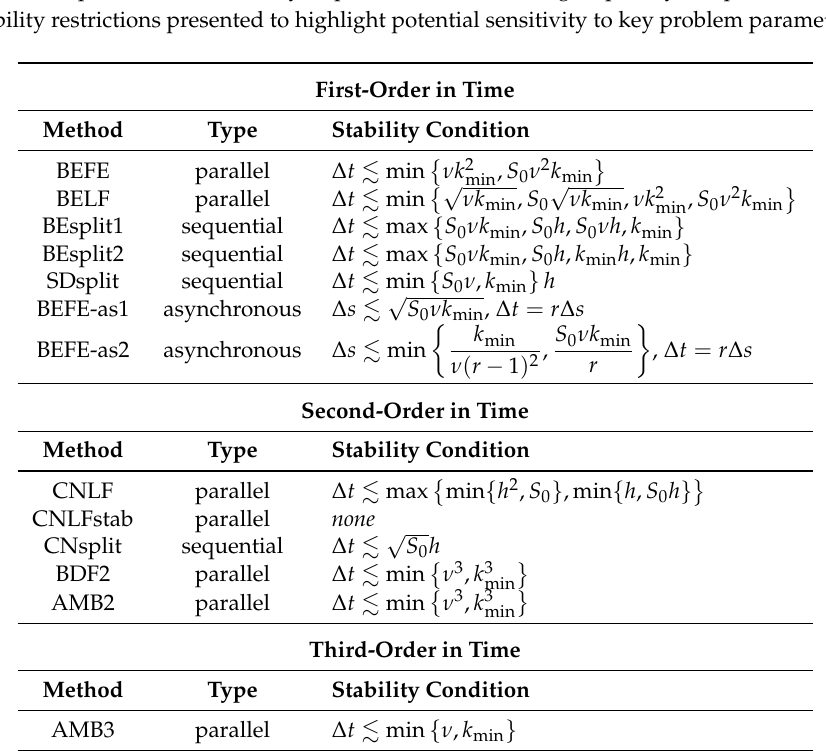
Table 3. A compilation of the surveyed partitioned methods, grouped by temporal convergence, with stability restrictions presented to highlight potential sensitivity to key problem